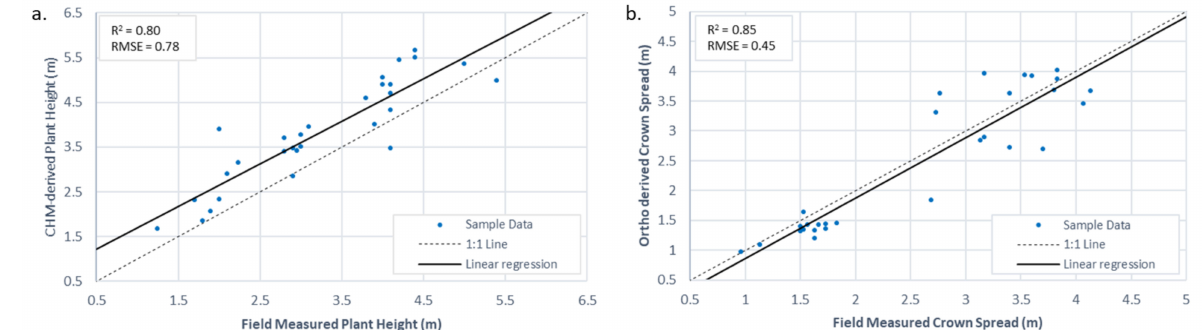
Figure 9. Scatterplot and linear regression of ( a ) banana plant height derived from the CHM created from UAV data and field-measured height, and ( b ) banana plant crown spread based on the orthomosaic created from UAV data and field-measured crown spread.